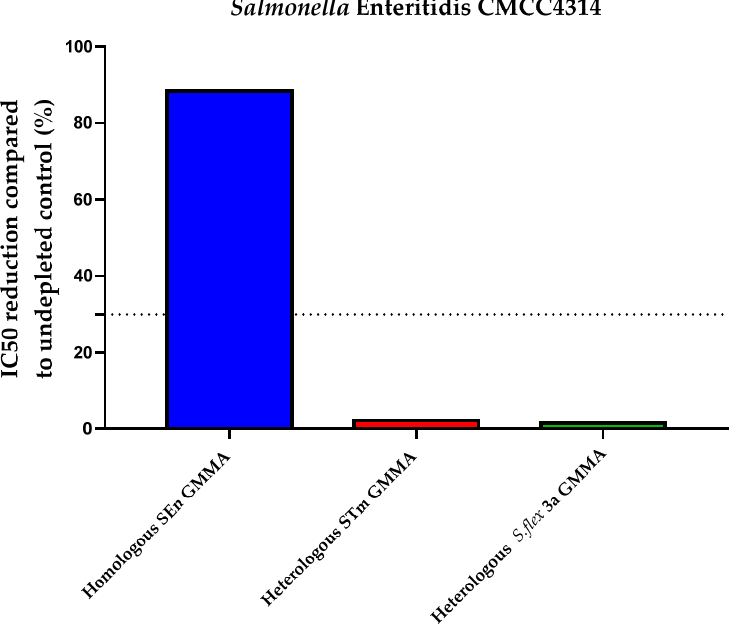
Figure 5. Heterologous specificity for Salmonella strains: percentage of IC50 inhibition observed compared to control inhibited with equal amount of PBS. Both assays resulted to be specific. STm: S. Typhimurium; SEn: S. Enteritidis; S. flex: S. flexneri . Table 3. Percentage of IC50 depletion compared to undepleted control in presence of homologous and heterologous competitors at concentration established in the previous set of experiments. Heterologous Specificity ( Percentage of Inhibition Compared to Undepleted Control ) S. Typhimurium S. Enteritidis